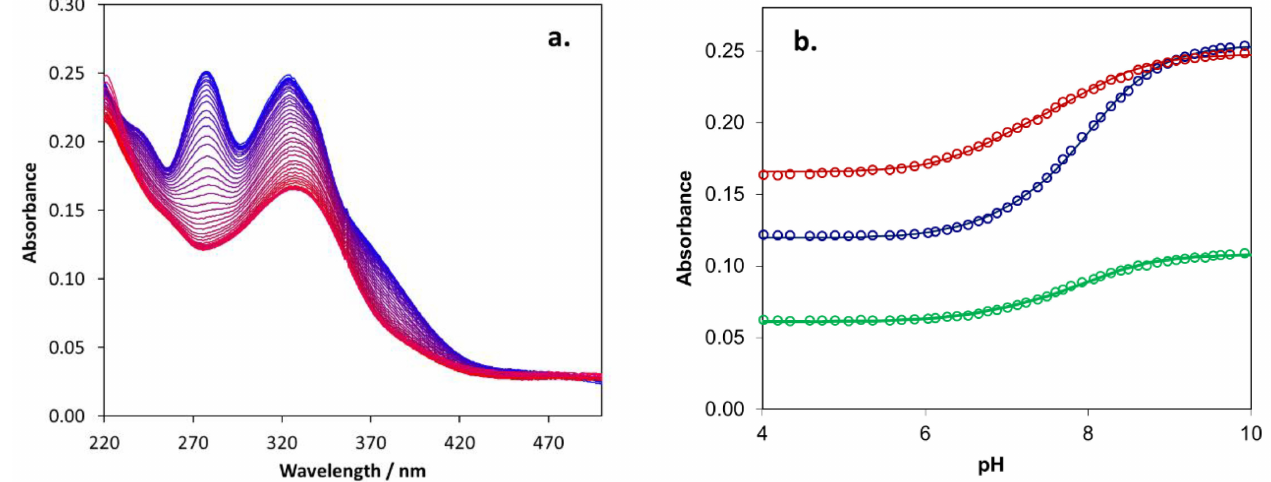
Figure 13. The measured absorption spectra ( a ) during potentiometric titration of ligand ( trans - 6 ). The pH changes from 10.0 (blue) to 4.0 (red). Subfigure ( b ) shows the measured (circles) and the calculated absorbance (lines) at three characteristic wavelengths (277 nm (blue), 324 nm (red), and 380 nm